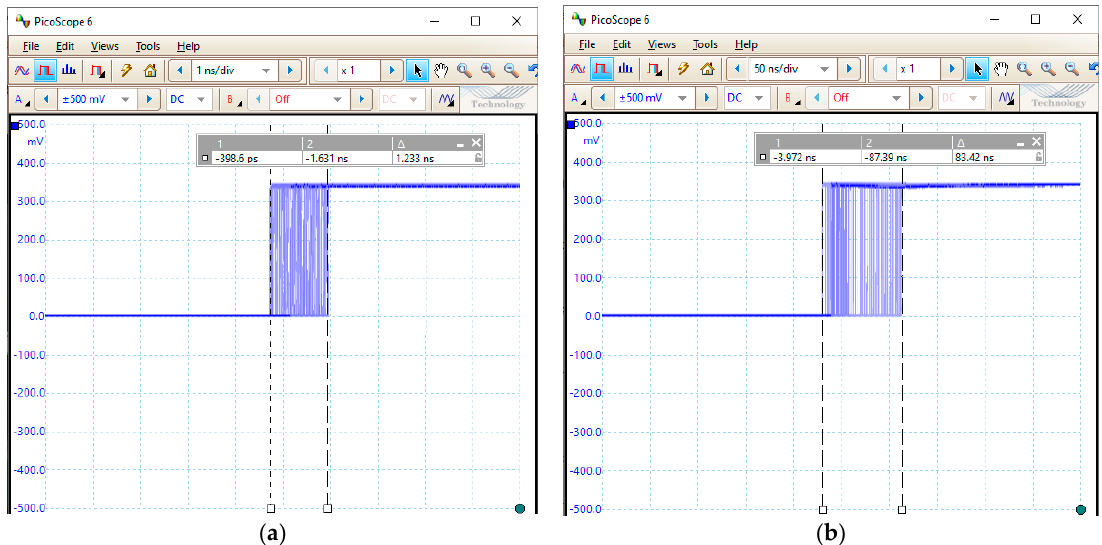
Figure 7. The jitter for the SYNC signal obtained for implementation on the ARM Cortex A53 core ( a ) and on an ARM Cortex R5 core ( b ).